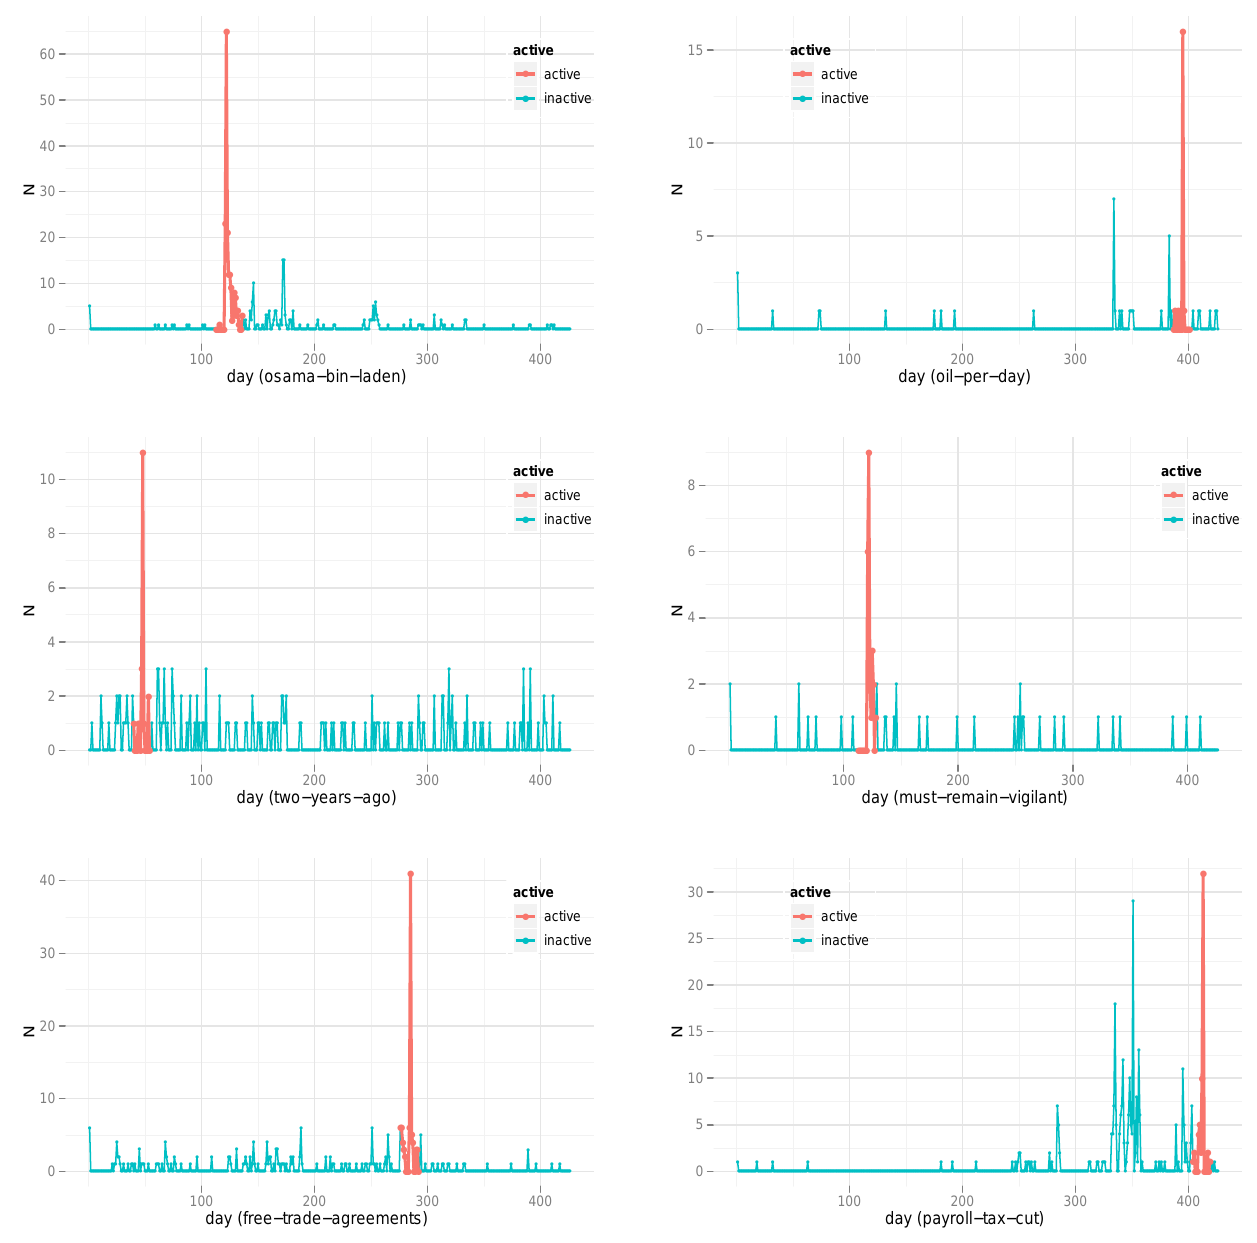
Figure 4. Examples of trigram infection instances. Note that a trigram may be associated with multiple non-overlapping bursts (e.g. “payroll-tax-cut” around day 350 and day 410), and each of the non-overlapping bursts is considered as a different infection